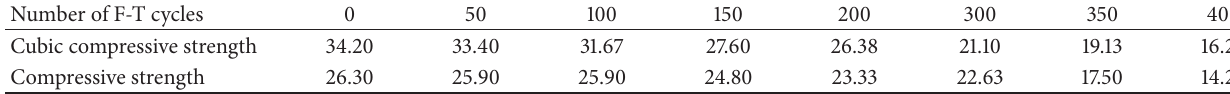
Table 2: Compressive strength of A-E-C after different cycles of F-T (MPa). Number of F-T cycles